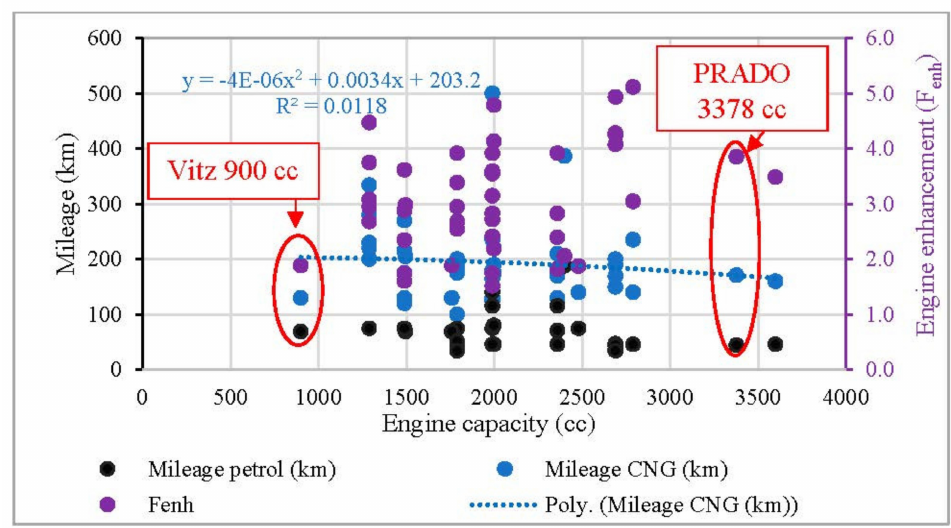
Figure 3. The comparison of mileage and engine enhancement for gasoline vehicles with different engine